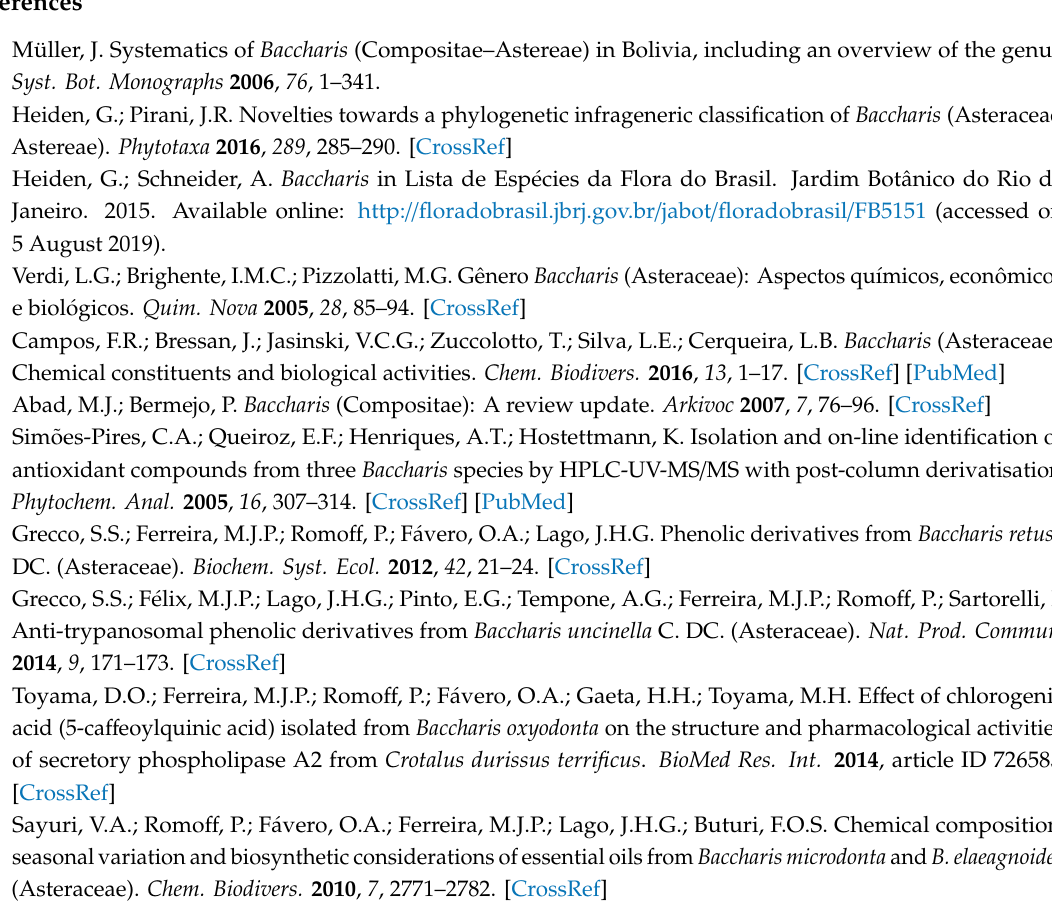
Supplementary Materials: The following are available online. Figures S1–S11: Spectral data of compounds 1 and